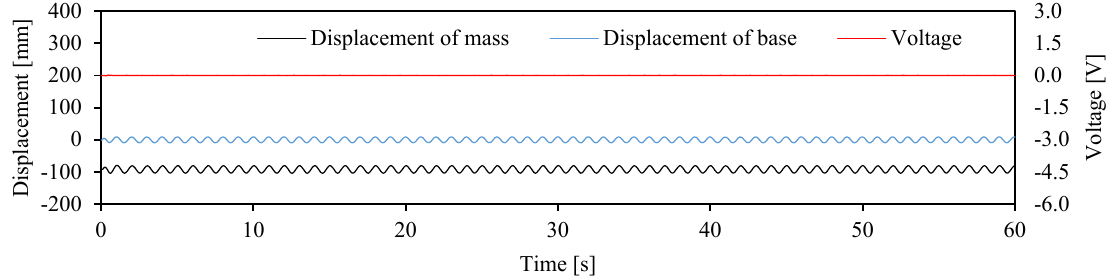
tion power of 1.99 mW.